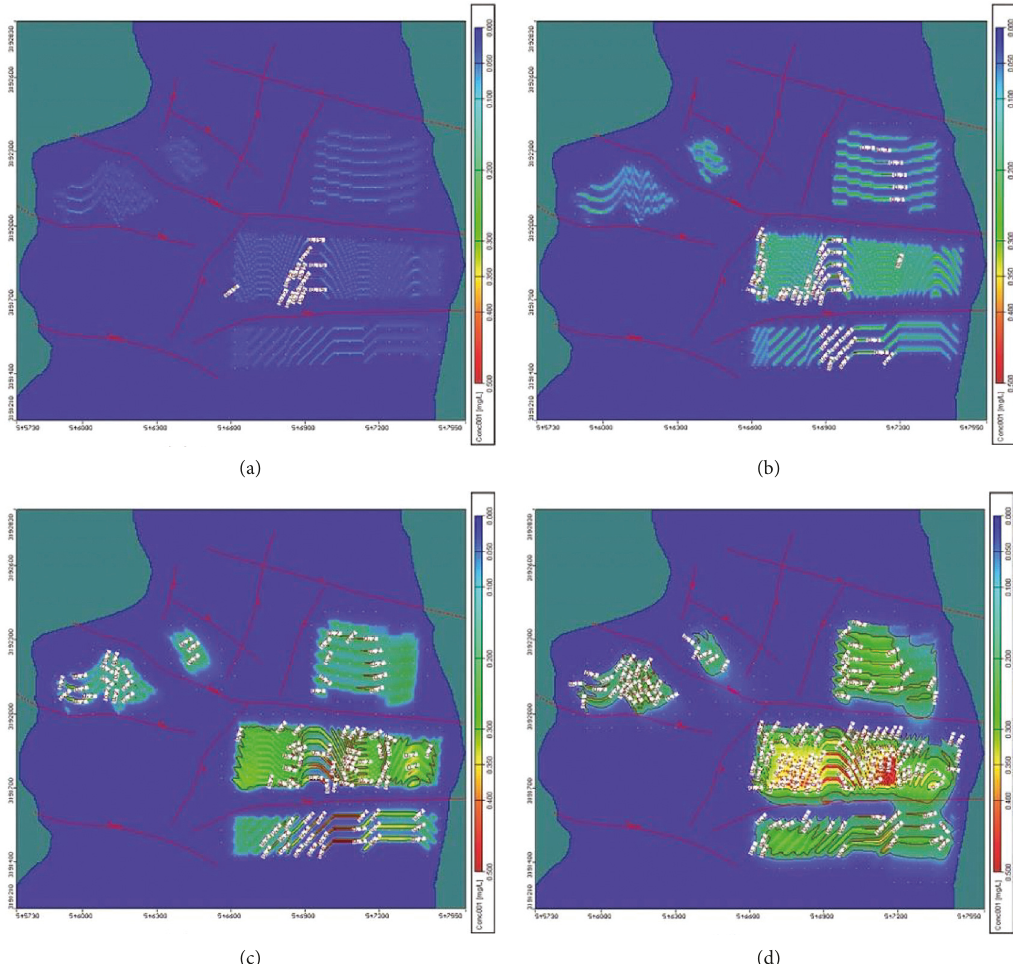
Figure 8: Total chromium pollution plume of disposal layer in the study